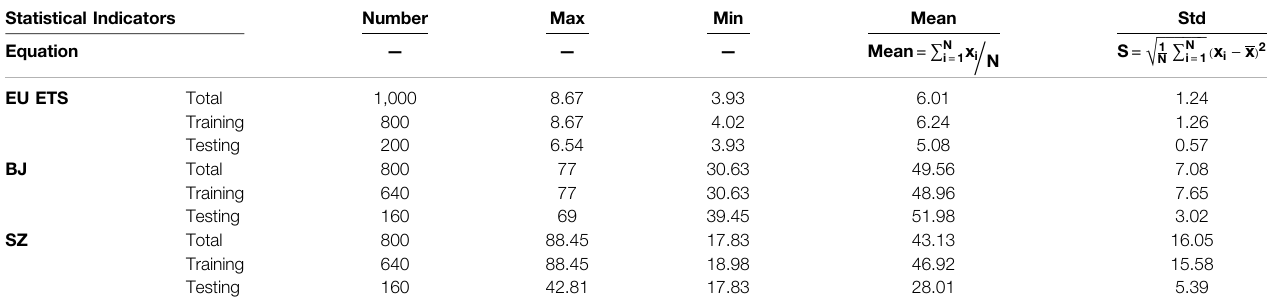
TABLE 2 | : Statistical description of the carbon prices reported at three sites. Statistical Indicators